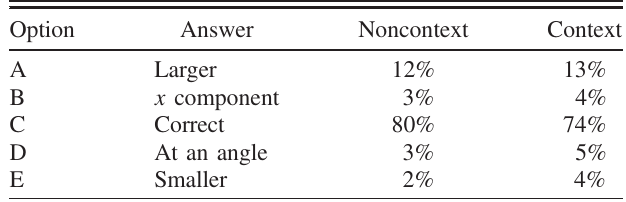
TABLE VIII. Results of item 3: Students have to choose the y component of a vector or force